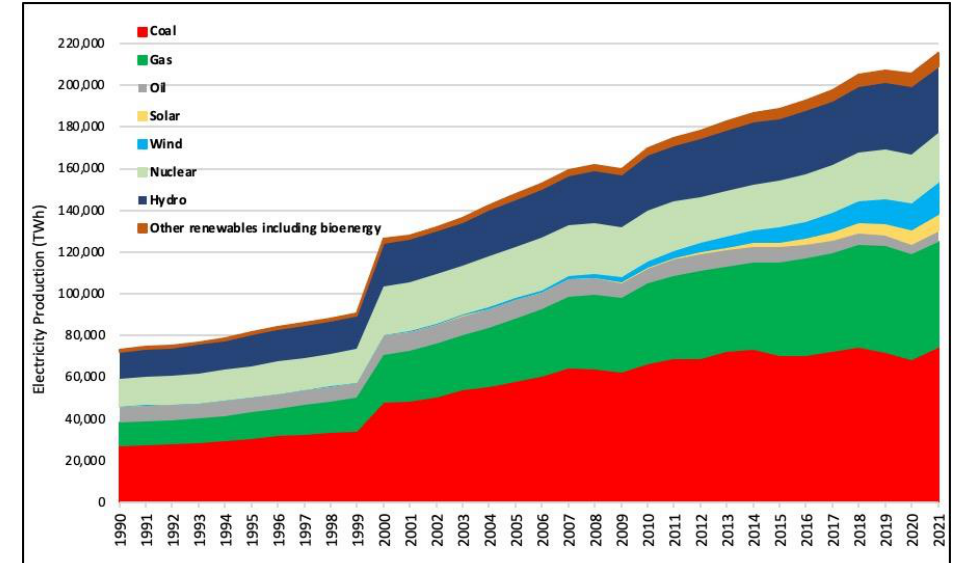
Figure 6. Global electricity production by source of fuel. Source of Data: International Renewable Energy Agency (IRENA) [124].